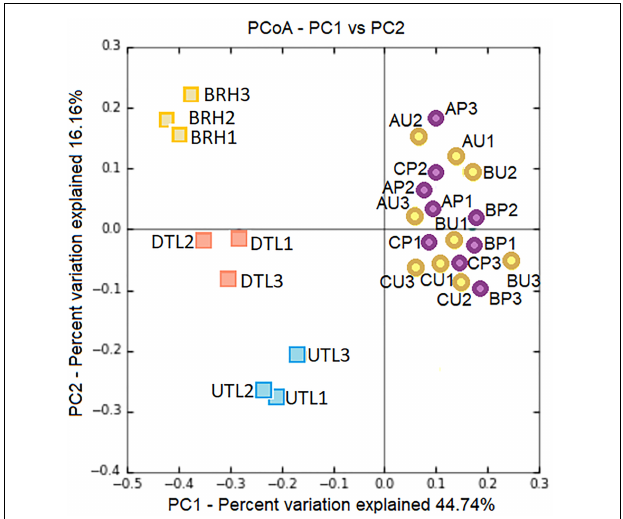
FIGURE 8 | PCoA based on Bray–Curtis distances shows clear patterns of separation by microbial composition among red damaged/undamaged tanned leathers (DTL/UTL), bovine rawhides (BRHs), three purple damaged/uncoloured-less damaged parchments (AP, BP, CP/AU, BU, CU). The number of each replicates (#1, 2, 3) is reported. The plot was generated on the base of an OTU table, Supplementary Table S2 , after concatenating seqs.fna files from the two projects (cat file1_seqs.fna file2_seqs.fna > combined_file_seqs.fna), mapping file merging (merge_mapping_files.py) and validation (validate_mapping_file.py), and dataset